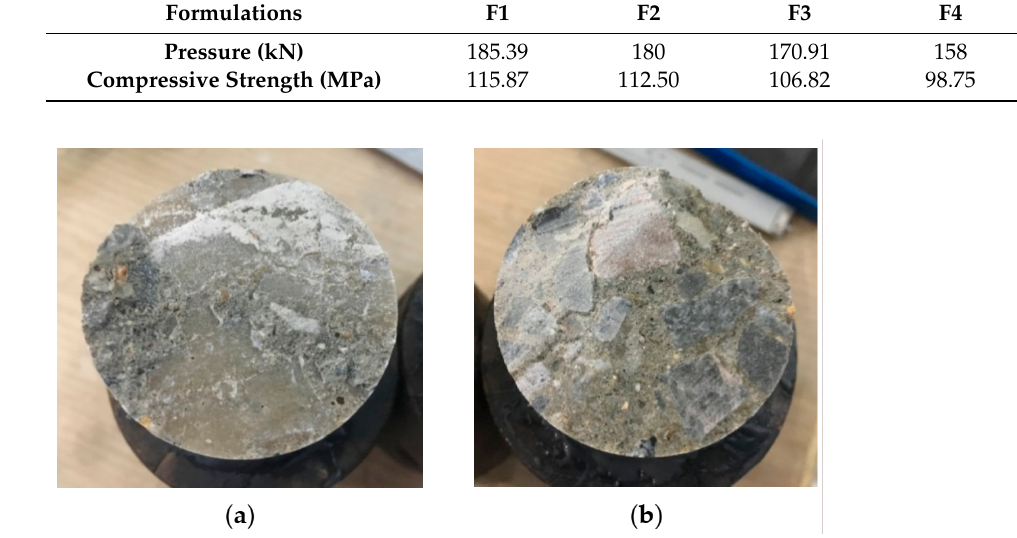
Figure 3. Debonding failures of the sample of F1 without cracks ( a ) lower end-face; ( b ) upper end-face.